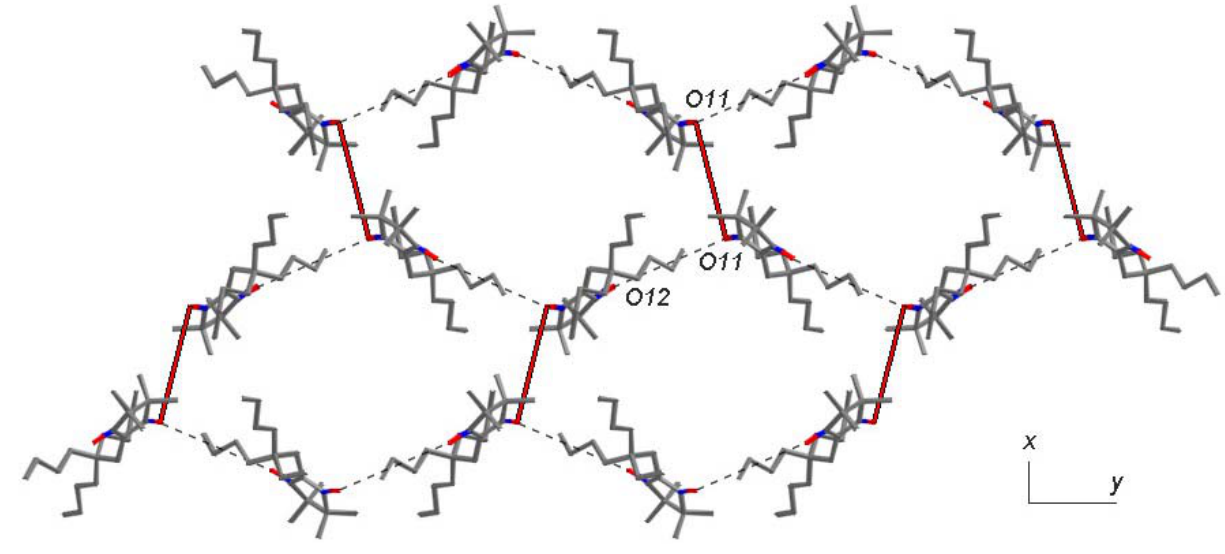
Figure 5. Projection of the crystal structure of 2 onto the ab plane. Dimeric units are denoted by red rods. Dashed lines refer to zigzag chains along the b